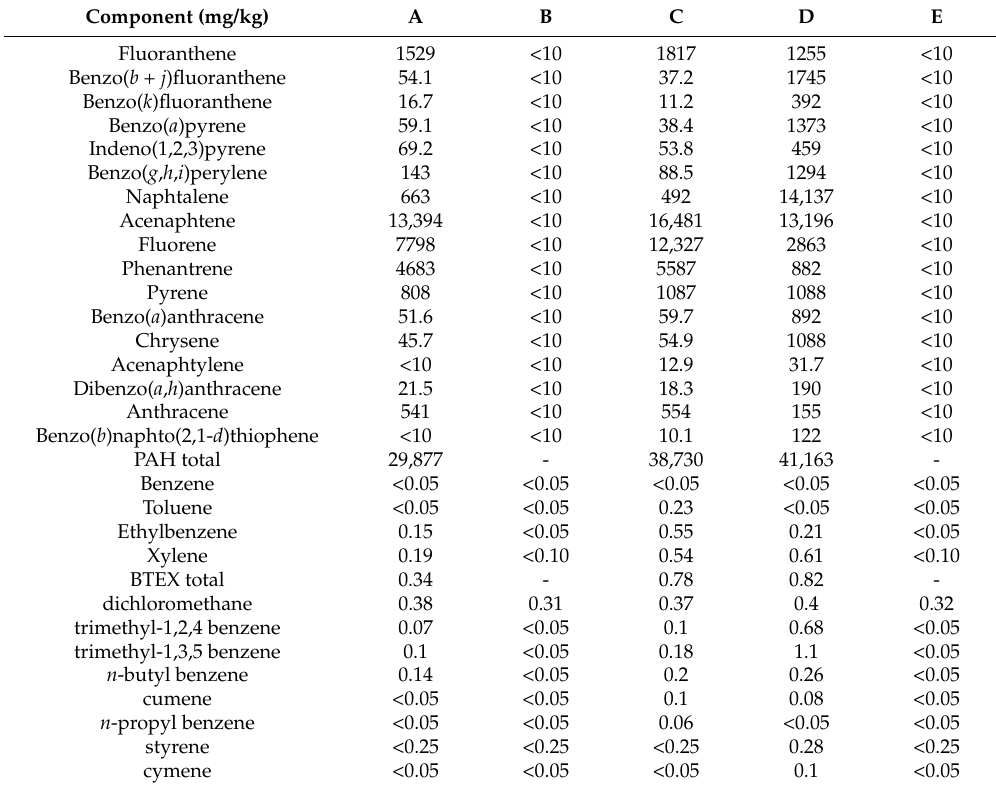
Table 2. Polycyclic aromatic hydrocarbons (PAH), benzene, toluene, ethylbenzene, xylene (BTEX), and volatile organic compounds (VOC) composition of the pastes in